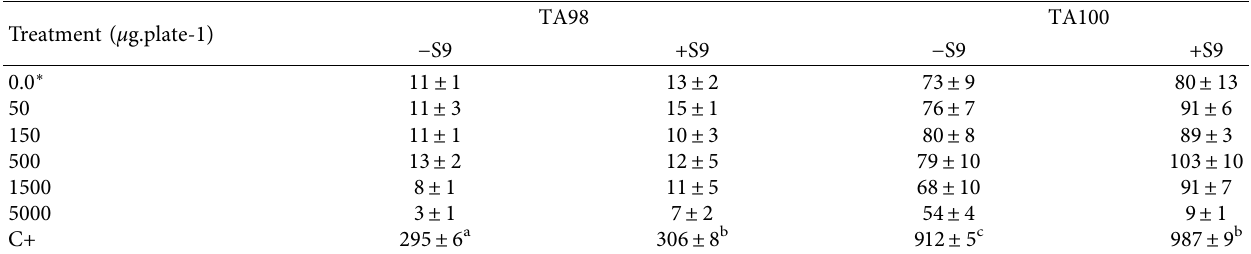
Table 1: Revertants per plate (mean and standard deviation) of S. typhimurium TA98 and TA100 strains after treatment with the (trifluoromethyl)phenyl-substituted compound in the presence and absence of metabolic activation. Treatment ( µ